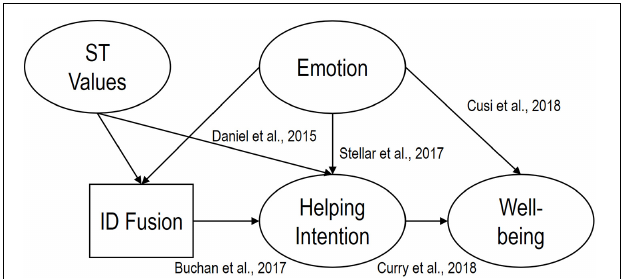
FIGURE 1 | Theoretical model of the effects of STEs. It represents the relationships tested in the present study through SEM analyses. Circles represent the relation measured by 2 or more items, while the square (identity fusion with all humanity), a single pictorial item. The model includes references to theoretical and/or empirical studies showing the relationships. ST Values, Self-Transcendent Values; ID Fusion, Identity Fusion. These models (i.e., one for each STE) as well as complete figures (with standardized coefficients), can be seen in Supplementary Materials